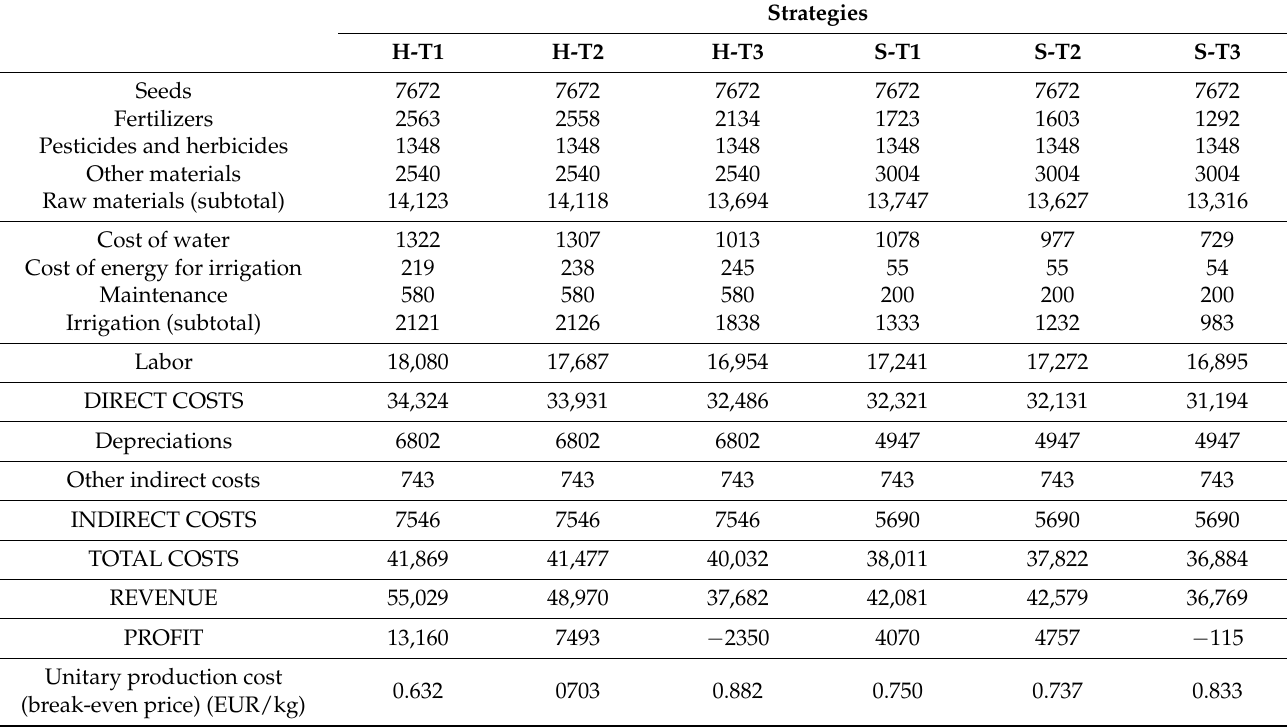
Table 4. Production cost structure and crop profitability for the different strategies (euros/ha).